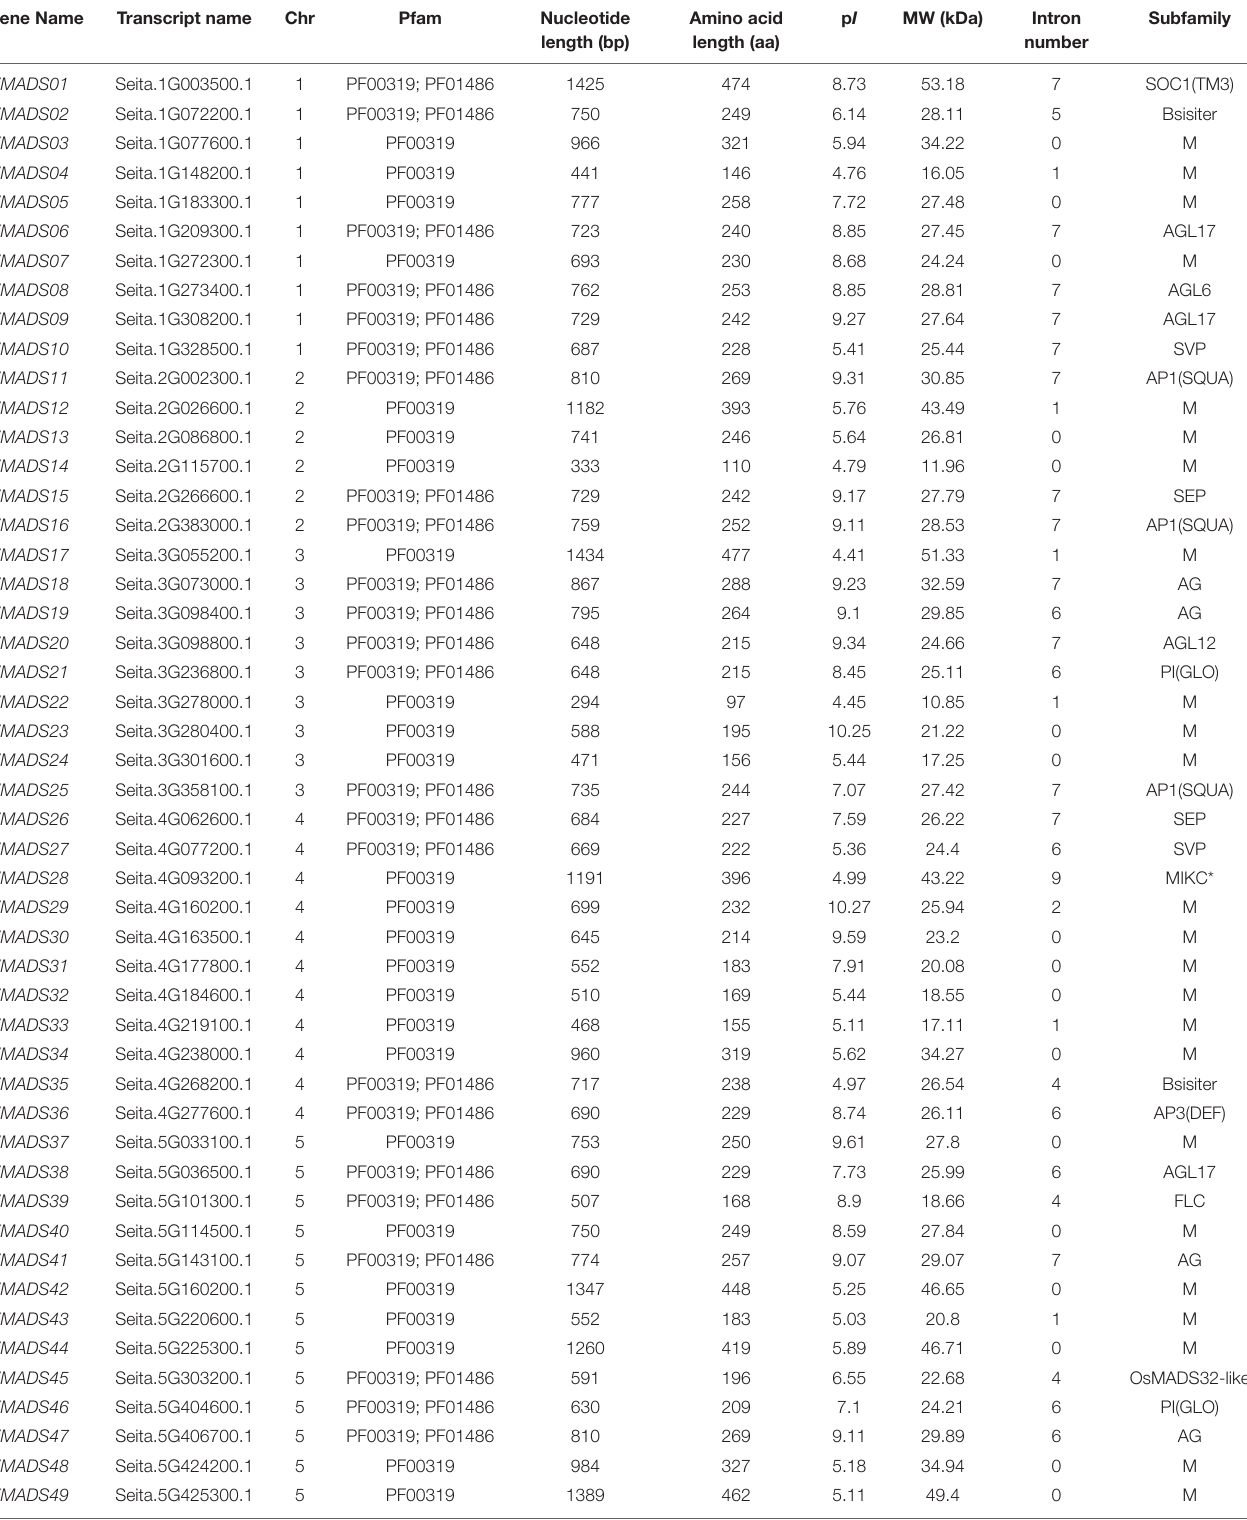
TABLE 1 | The detailed information of 72 MADS-box genes identified in foxtail millet